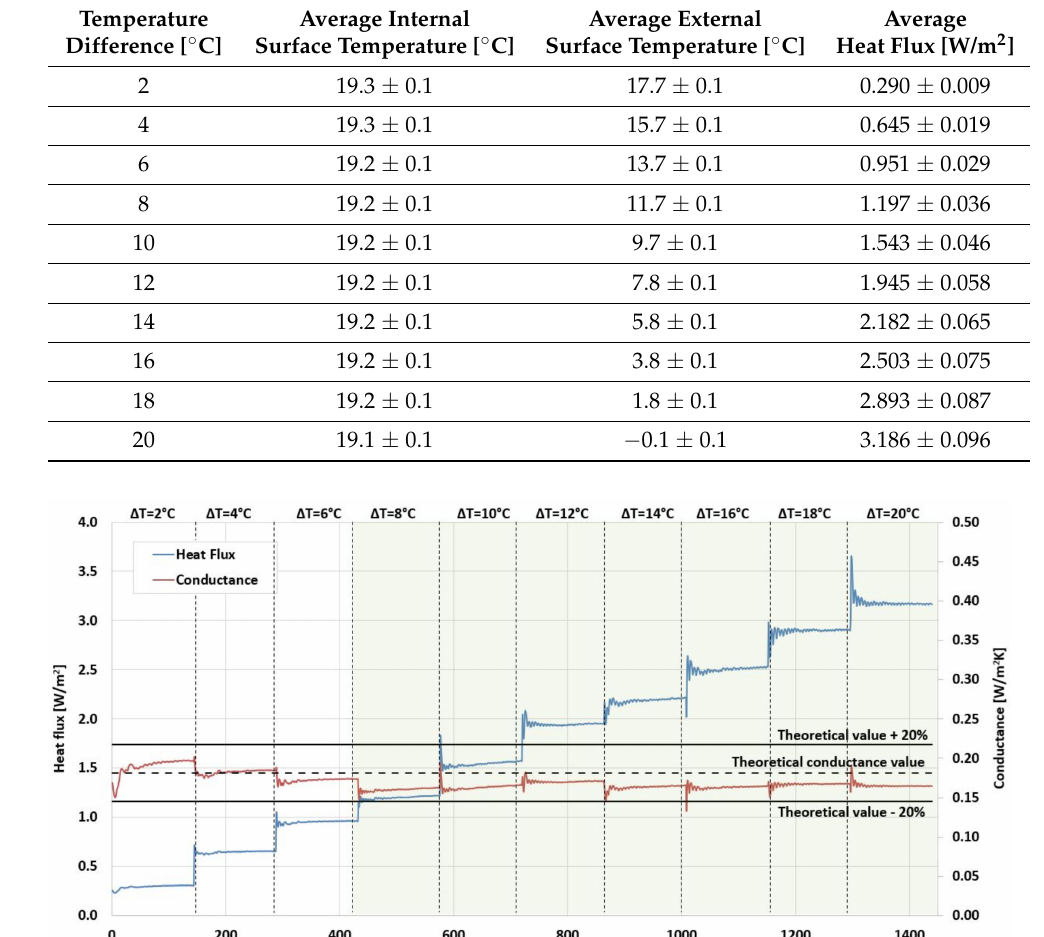
Table 3. Average surface temperatures and heat flux obtained for the different tests.